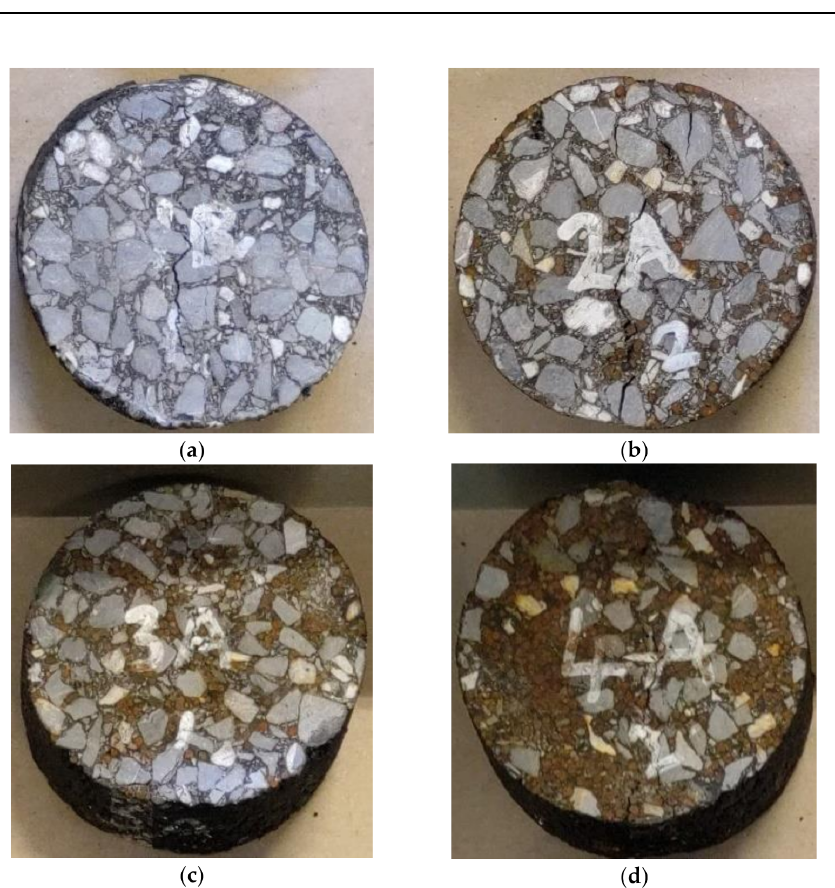
Figure 7. The 10 mm SMA mix containing varying amounts of capsules: ( a ) 0% capsules, ( b ) 5% capsules, ( c ) 10% capsules and ( d ) 20%